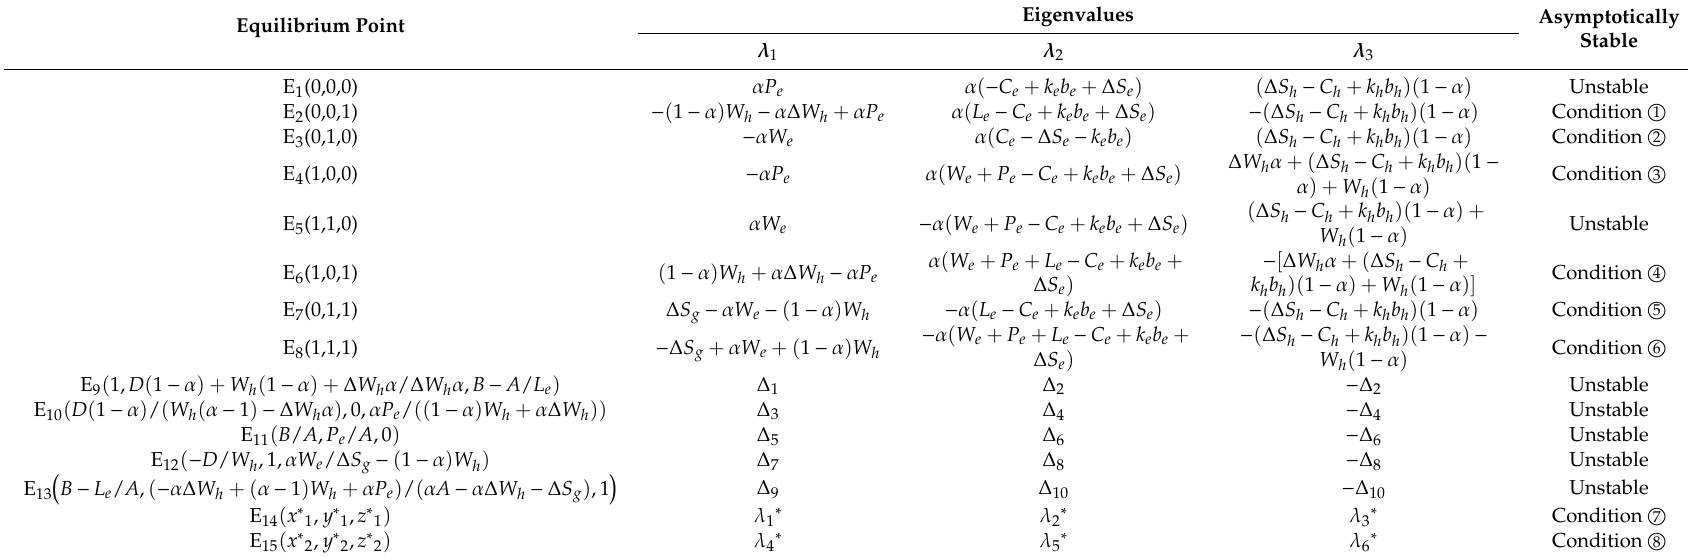
Table 2. The evolutionary stable strategies and eigenvalues of the